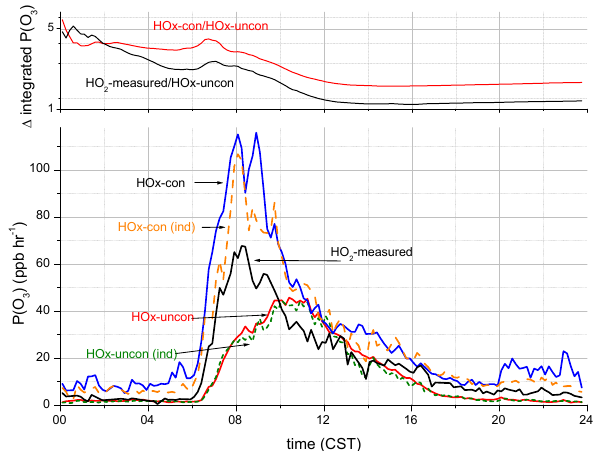
Fig. 7. The median diurnal profile for ozone production for in- dividual day modeling is shown for the HO x -constrained (orange line) and HO x -unconstrained (green line), as well as for the median- model runs for HO x -constrained (blue line) and HO x -unconstrained (red line). HO 2 is shown as the black line. The top panel results from di- viding the integral of the median P (O 3 ) HO by the median x - con P (O 3 ) HO (red line) and median P (O 3 ) HO by the me- x - uncon 2 - con dian P (O 3 ) HO (black x - uncon